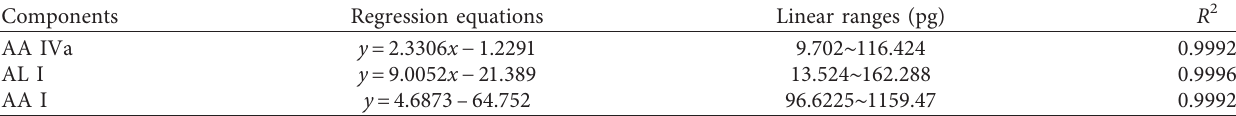
Table 2: Regression equations, linear ranges, and coefficients for AA IVa, AL I, and AA I. Components